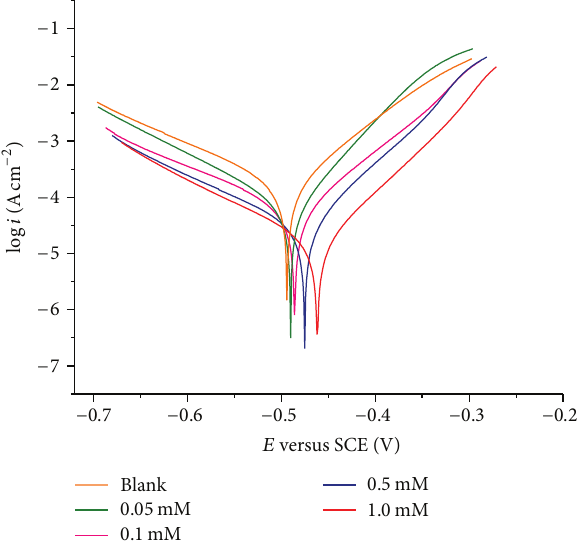
Figure 7: Polarisation curves for mild steel in 1M HCl in the presence of various concentrations of